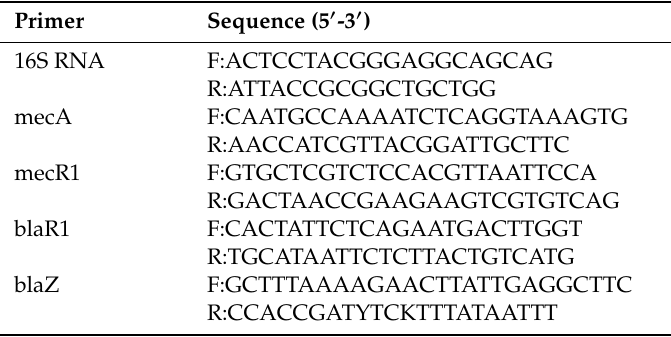
Table 3. Primers used in quantitative RT-PCR